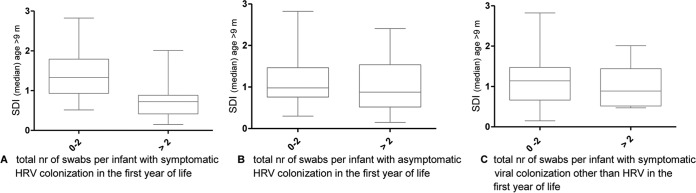
SDI at the end of the first year of life in relation to the number of viral colonizations throughout the whole year. Shown are the median SDIs of the nasal swabs taken in the last 3 months of the study period (box plots with minimum to maximum) grouped as from zero to two positive swabs and as more than two positive swabs for (A) symptomatic HRV (0 to 2, n = 18; >2, n = 13), (B) asymptomatic HRV (0 to 2, n = 20; >2, n = 11), and (C) symptomatic viral infections other than HRV (0 to 2, n = 21; >2, n = 10). Coinfections are only included for symptomatic viral infections other than HRV. A lower SDI was found in infants with more frequent symptomatic HRV colonization (P = 0.015) but not with more frequent asymptomatic HRV colonization (P = 0.2) or more frequent symptomatic viral colonization other than HRV (P = 0.1).